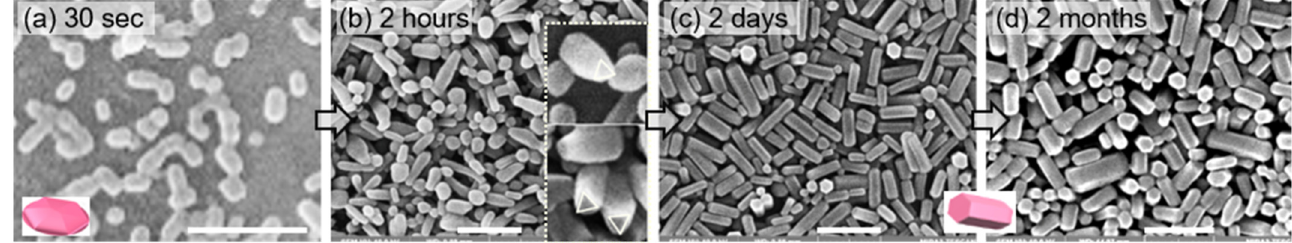
Figure 4. SEM images showing growth process into hexagonal rods as a function of storage time of turbid 10 μ M THF-H 2 O mixtures (1/4, v / v ). ( a ) 30 s, ( b ) 2 h, ( c ) 2 days, and ( d ) 2 months. The inset photographs in ( b ) are magnified SEM images showing bowling pin-shaped structures. Scale bar: 500 nm.